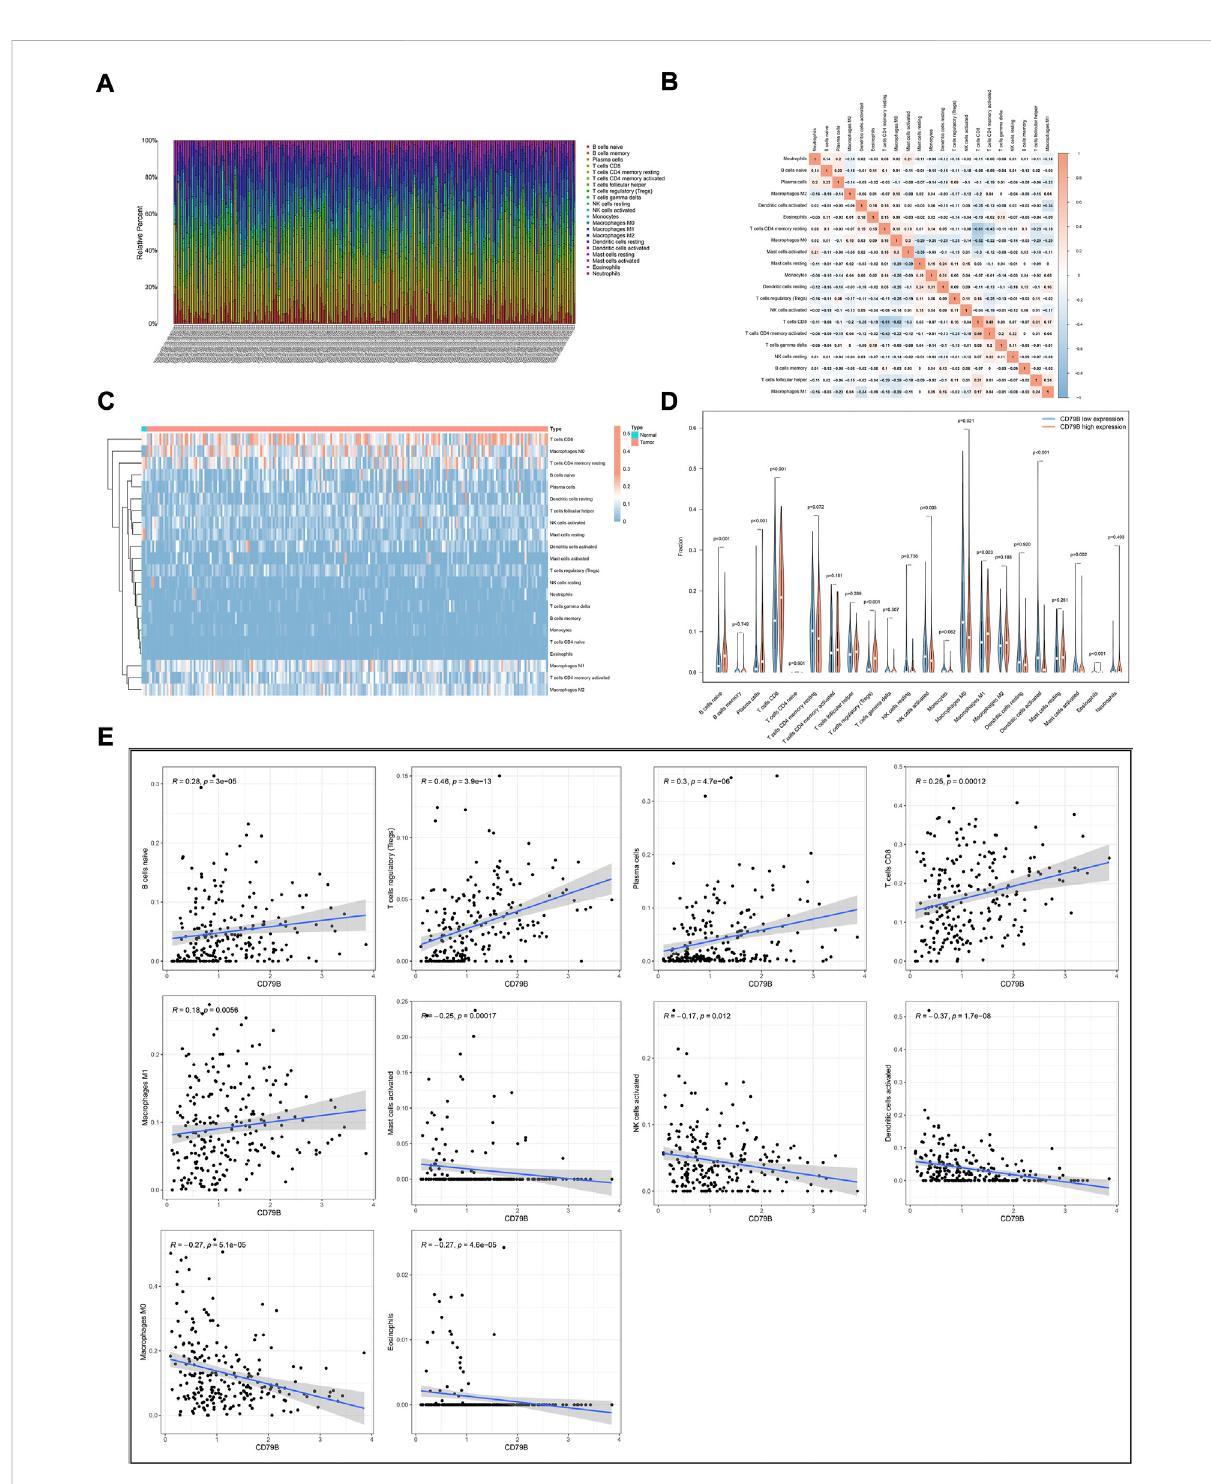
FIGURE 5 Correlation analysis of CD79B expression and TICs. (A) The proportions of 22 types of TICs in the TCGA-CESC cohorts. (B) Corrplots for the correlation among the 21 TICs populations. (C) Heatmaps showing the differences in TIC abundance between tumor and normal tissues in CESC cohorts. (D) Violinplotsfortheproportionsof22TICsinsampleswithlowandhighCD79Bexpression. (E) ScatterplotshowingPearson ’ scorrelation between TICs and CD79B expression ( p < 0.05). The 10 types of TICs were signi fi cantly different between the high and low CD79B expression groups. The blue lines in each plot denote the best- fi t linear